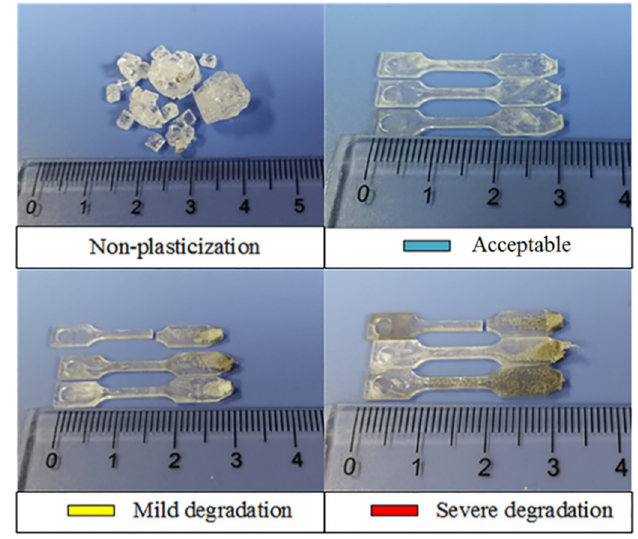
Figure 6. Representative samples obtained under Mode 2.